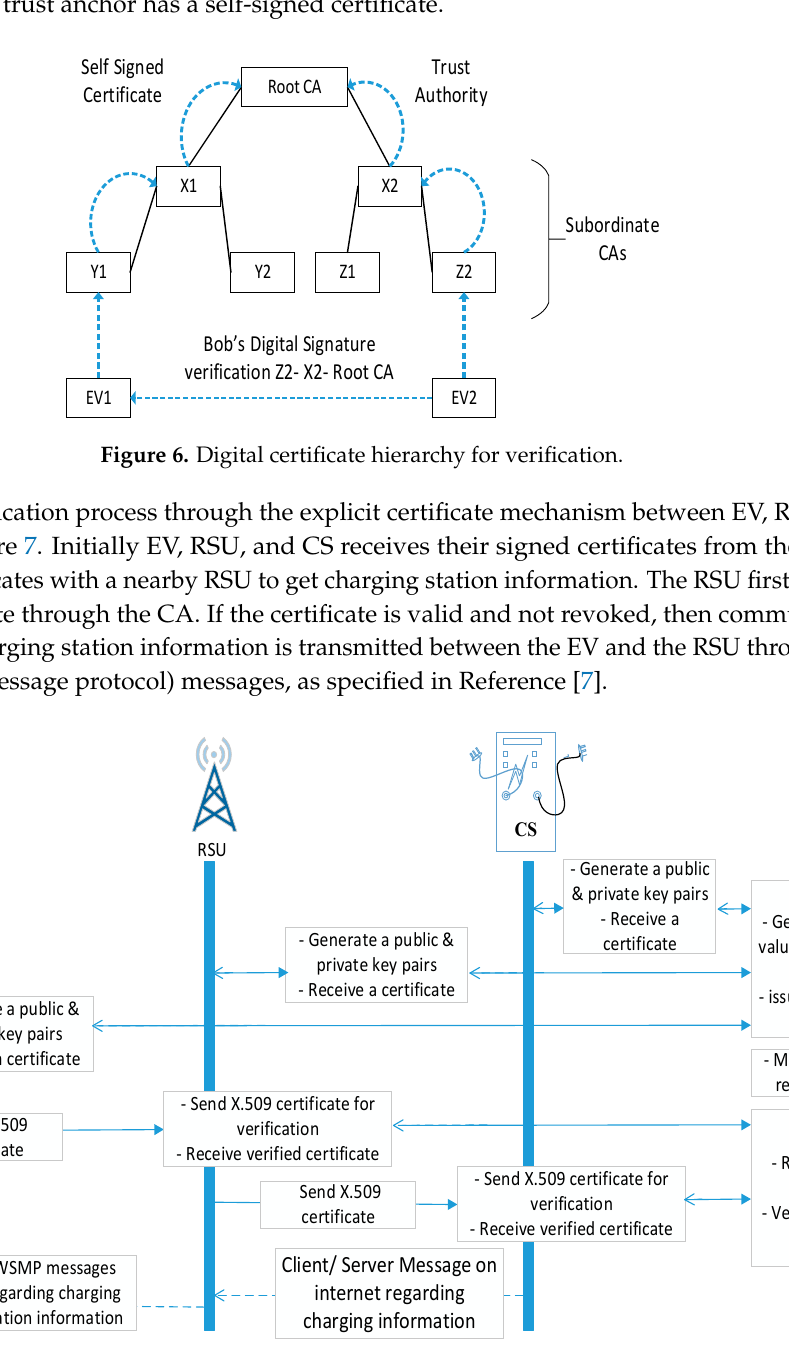
Figure 7. Message exchanges for explicit certificate-based authentication process.